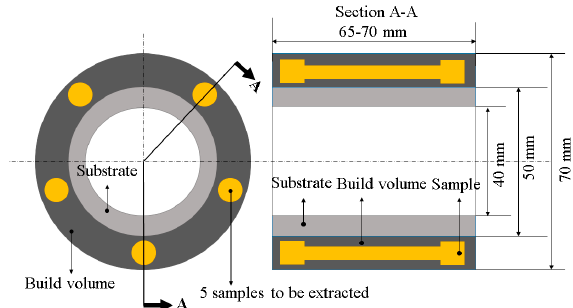
Figure 7. Tensile sample manufacturing scheme and geometry of the volume built up.